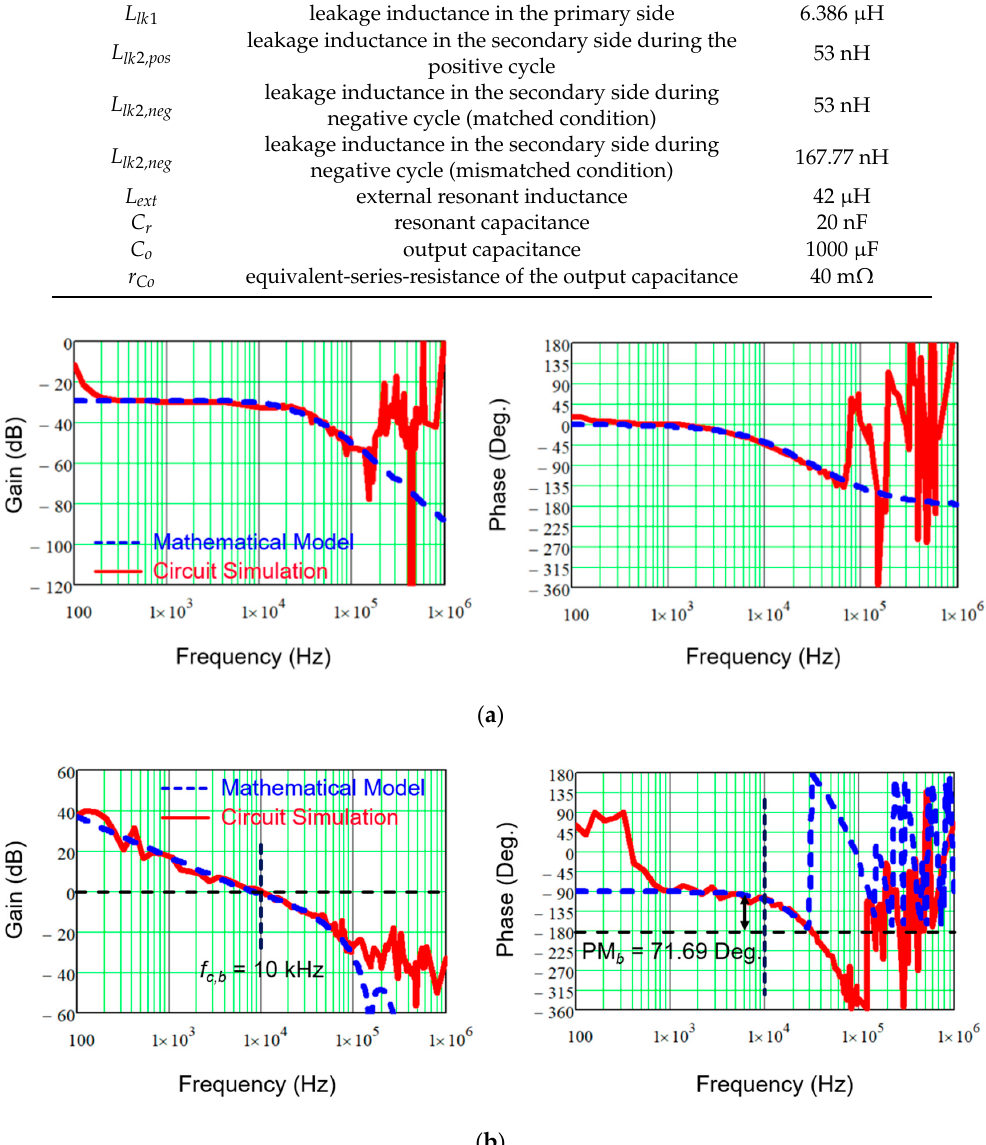
Figure 14. Bode plot of the flux-balance loop gain ( a ) uncompensated and ( b ) compensated.